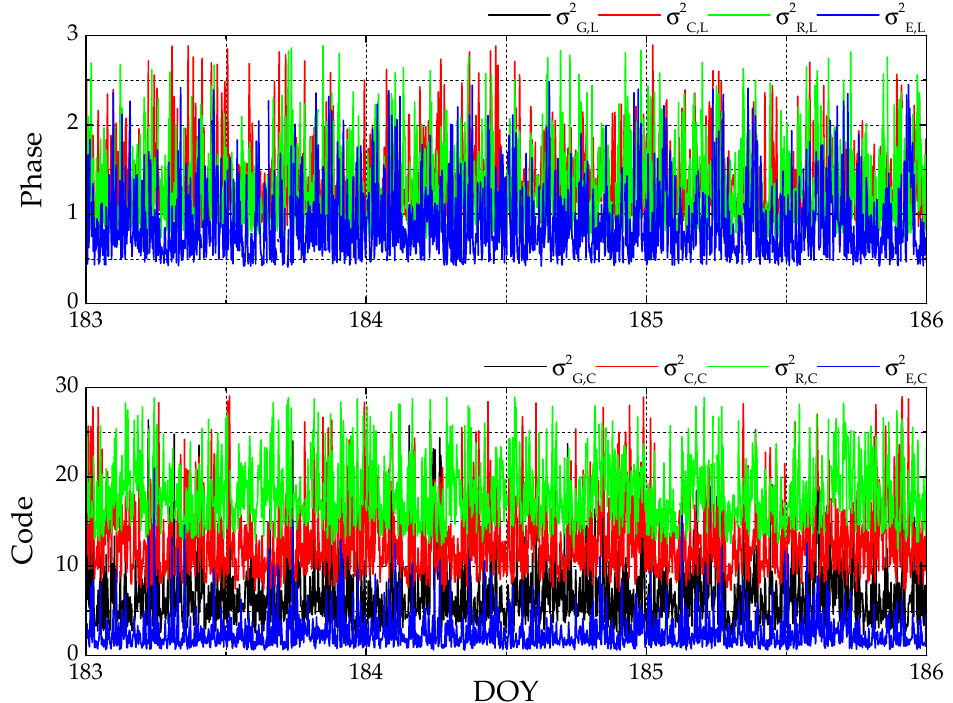
Figure 3. Time series of variances of unit weight of phase ( top ) and code ( bottom ) for baseline South Africa (SUT) from day of year (DoY) 183 to 186 in 2019.